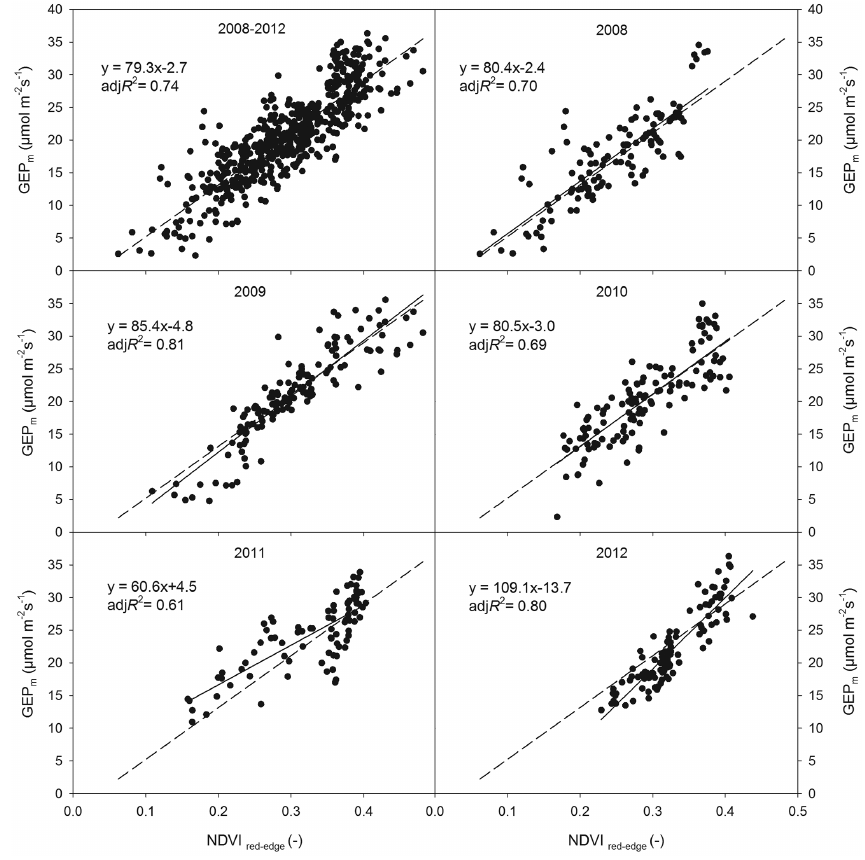
Figure 4. Relationship between the red-edge normalized difference vegetation index (NDVI red-edge ) and mean midday gross ecosystem production (GEP m ), considering both the 5 years of observation together and annual observations. Dashed and solid trend lines refer to the general model 1 (considering each year of observation) and model 1 based on the observations from a specific year, respectively.